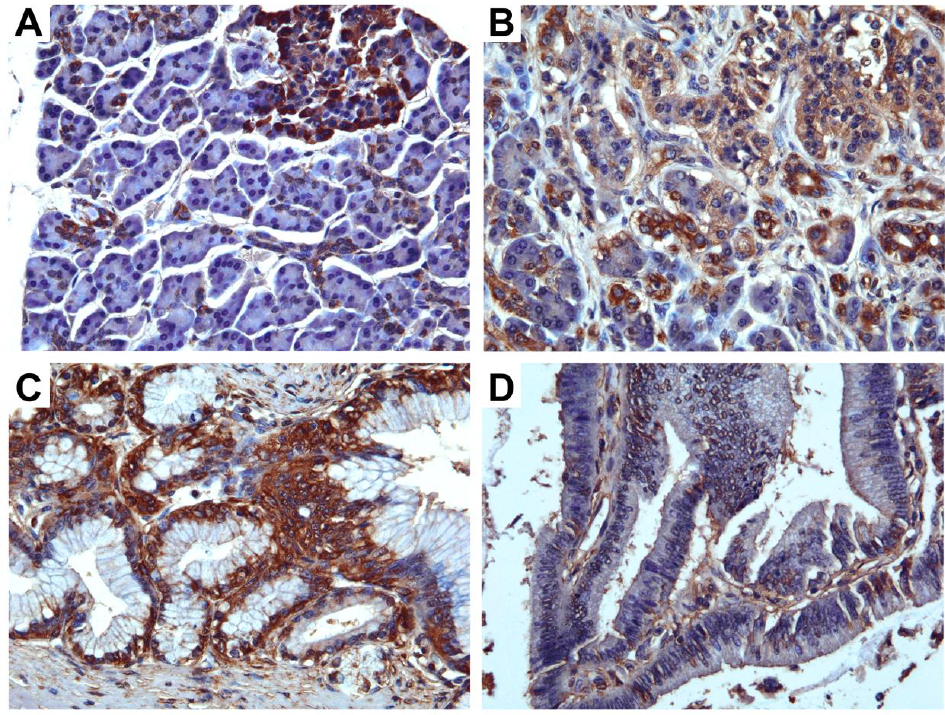
Figure 1. Immunohistochemistry using anti-TRPM8 in pancreatic tissues. ( A ) Normal pancreatic tissues. ( B ) Chronic pancreatitis. ( C ) Pancreatic intra-epithelial neoplasm. ( D ) Intraductal papillary mucinous